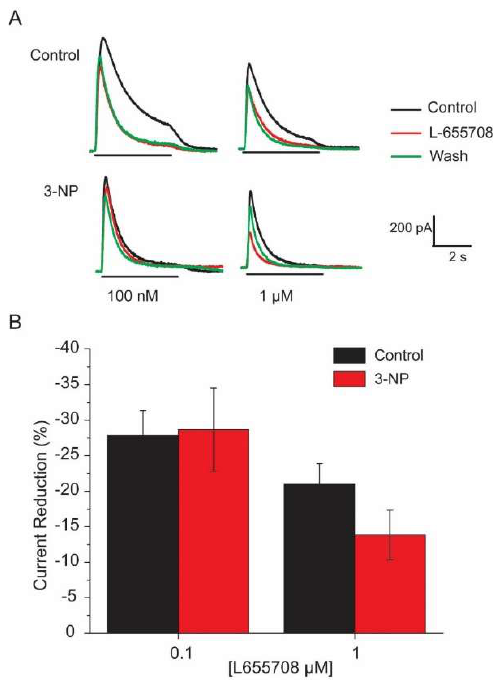
Figure 7. L-655708 effects on GABA induced current. ( A ) Representative traces of the current generated by GABA in the presence of 100 nM and 1 µM L-655708 in the MSNs of the control and 3-NP groups. ( B ) Plot of the GABA induced current reduction in the presence of two different concentrations of L-655708.